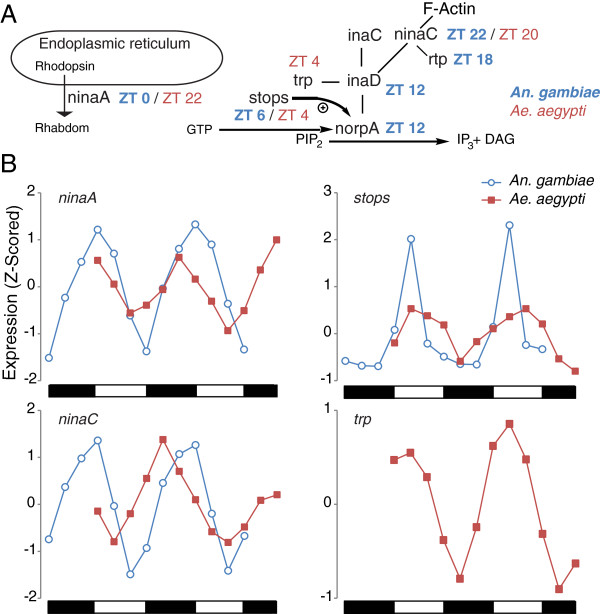
Multiple components of the visual transduction cascade are rhythmically expressed and in similar phases in both An. gambiae and Ae. aegypti. (A) Mosquito homologues to genes in the Drosophila phototransduction cascade signaling complex were identified as rhythmic in LD heads using the JTK_CYCLE algorithm (q < 0.05). Peak phase in expression is indicated next to gene names as Zeitgeber time (ZT) with An. gambiae genes in bold blue and Ae. aegypti genes in red. (B) Transcription profiles of genes rhythmic in both species as well as Ae. aegypti transient receptor potential (trp). An. gambiae trp expression was not detected above background levels. Expression values are Z-scored. Day and night are indicated by the horizontal white/black bars below the chart. The shift in the presentation of the beginning and end of expression profiles reflects differences in experimental design between Anopheles and Aedes collections. Mosquito visual gene identities and functions are based on homology to Drosophila and are presumed similar in Anopheles and Aedes mosquitoes [120,121,126]. For the full set of An. gambiae vision genes found rhythmic, see Rund et al. 2011 [30]. All data shown are from LD heads.